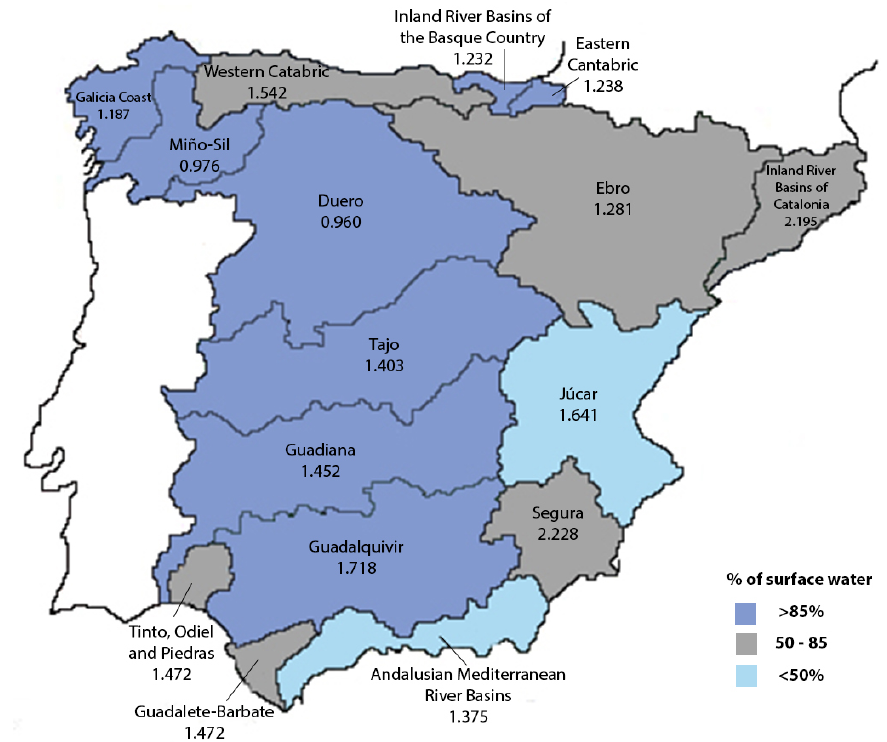
Figure 2. Average price of urban water cycle (in €/m 3 ) and water source in the peninsular Spanish River Basins Districts. Source: Own elaboration from